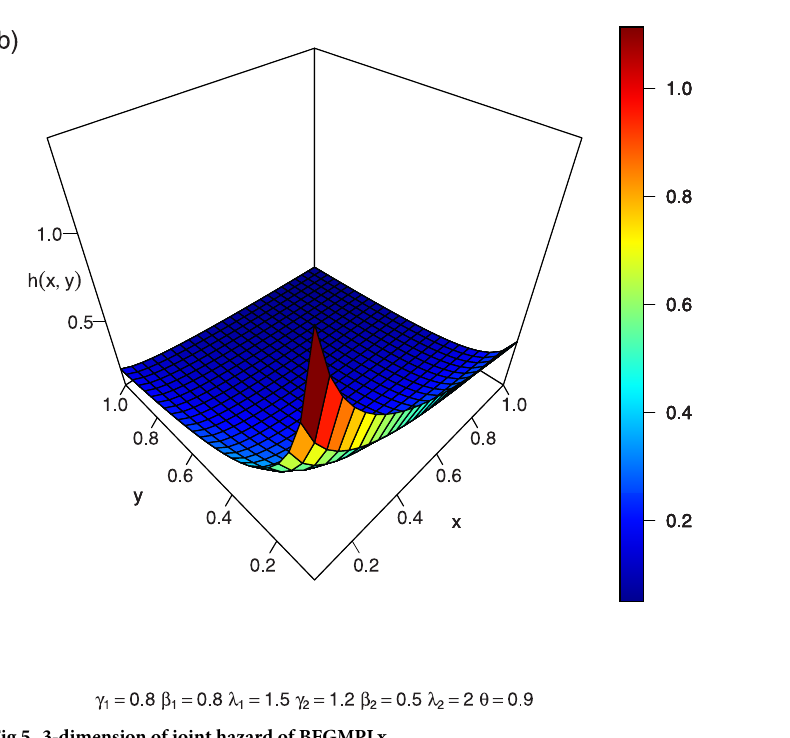
Fig 5. 3-dimension of joint hazard of